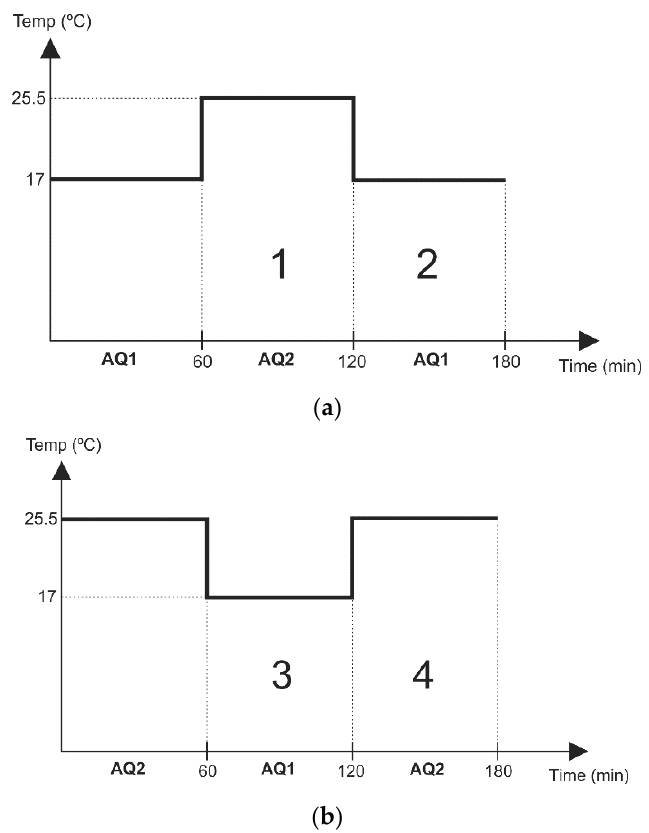
Figure 3. ( a ) Temperature profiles for Experiment 1; ( b ) temperature profiles for Experiment 2. The order of experiment 1 is inverted.